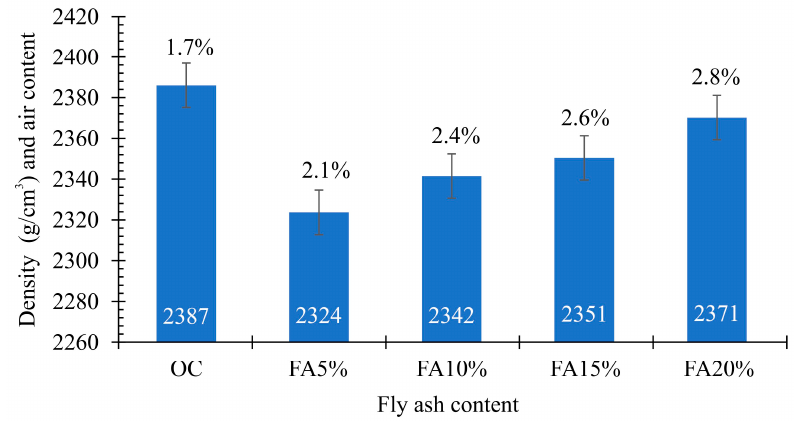
Figure 6. Air content and density of the concrete mixes.